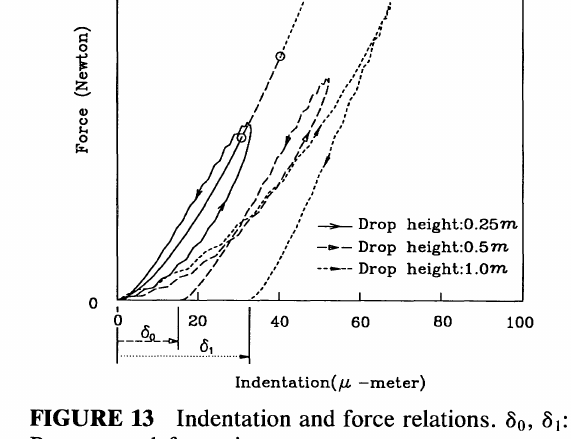
FIGURE 13 Indentation and force relations. 8 0, 8 1: Permanent deformation